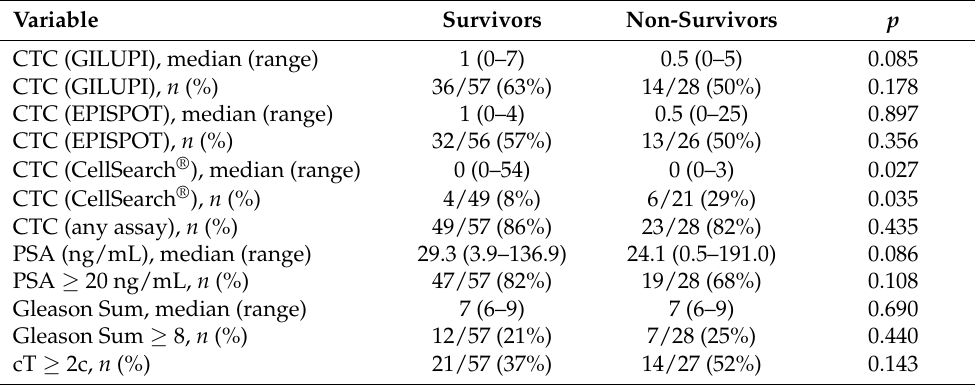
Table 6. Baseline CTC counts detected using the GILUPI CellCollector, EPISPOT assay and CellSearch ® system and clinical characteristics of 85 patients with localized PCa at baseline, ac- cording to survival during the follow-up period.